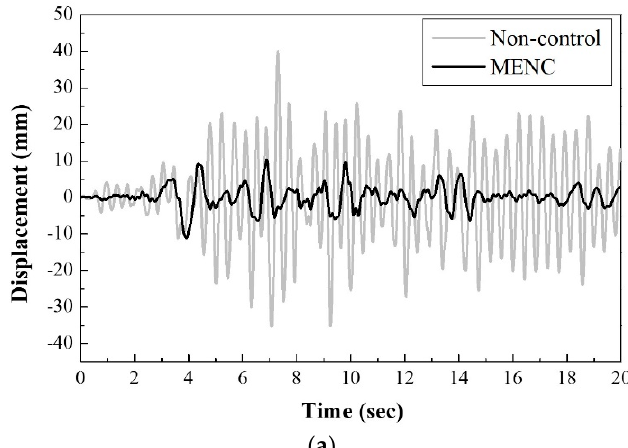
Figure 7. Control signal and control force of the AMD system under the seismic loads: ( a ) California earthquake; ( b ) Northridge earthquake; ( c ) Landers earthquake; ( d ) Cape earthquake; ( e ) San Simeon earthquake; ( f ) Loma Prieta earthquake.